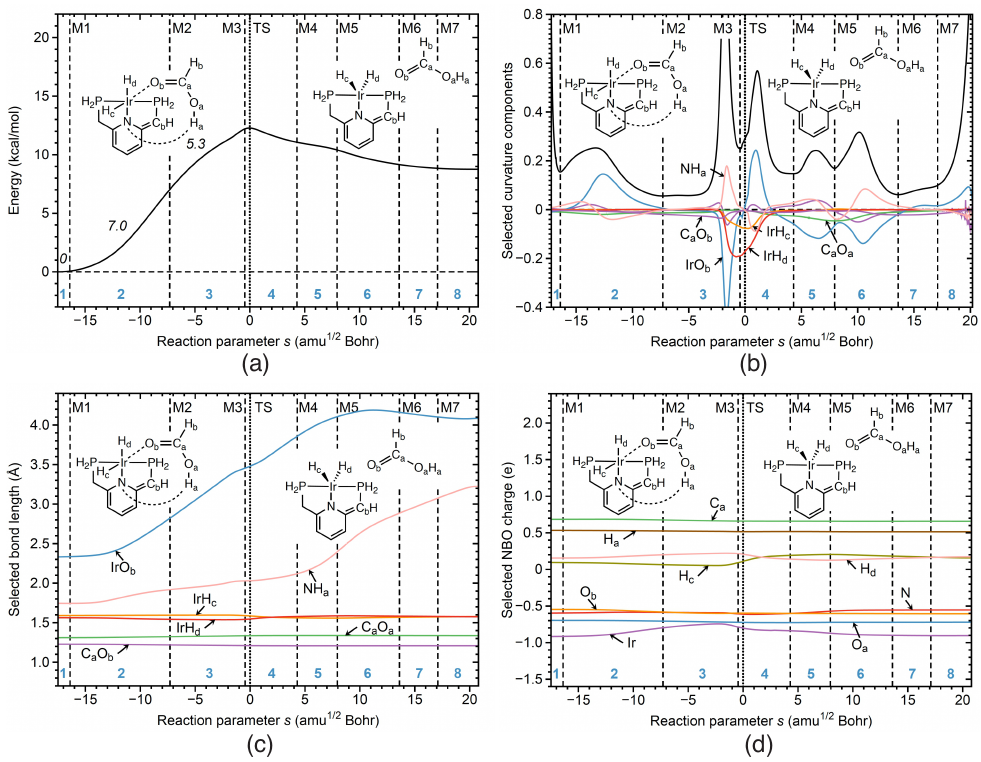
(d) Figure 7. Properties of reaction R3 of the catalytic cycle along the reaction path. ( a ) Energy profile, energy contributions of each reaction phase to the activation energy are indicated by italic numbers; ( b ) decomposition of the reaction curvature into selected components; ( c ) change of selected bond lengths along s ; ( d ) change of selected NBO atomic charges along s . Positions of the curvature minima are shown as dashed vertical lines and are labeled as M1, M2, and so on. The position of the TS is indicated by a dotted line. Reaction phases are indicated by blue numbers. B3LYP/6- 31G(d,p)/SDD(Ir) level of